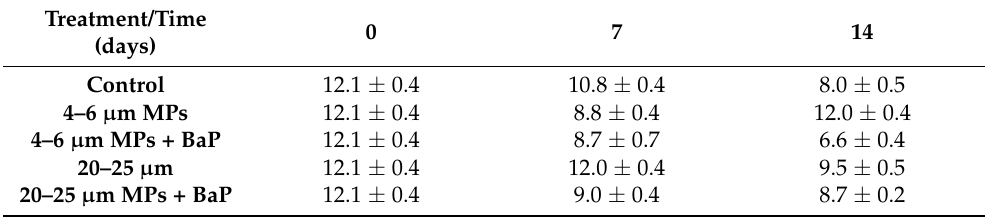
Table 1. Condition index (mean ± SD) from each treatment (control, 4–6 µ m MPs, 4–6 µ m MPs+